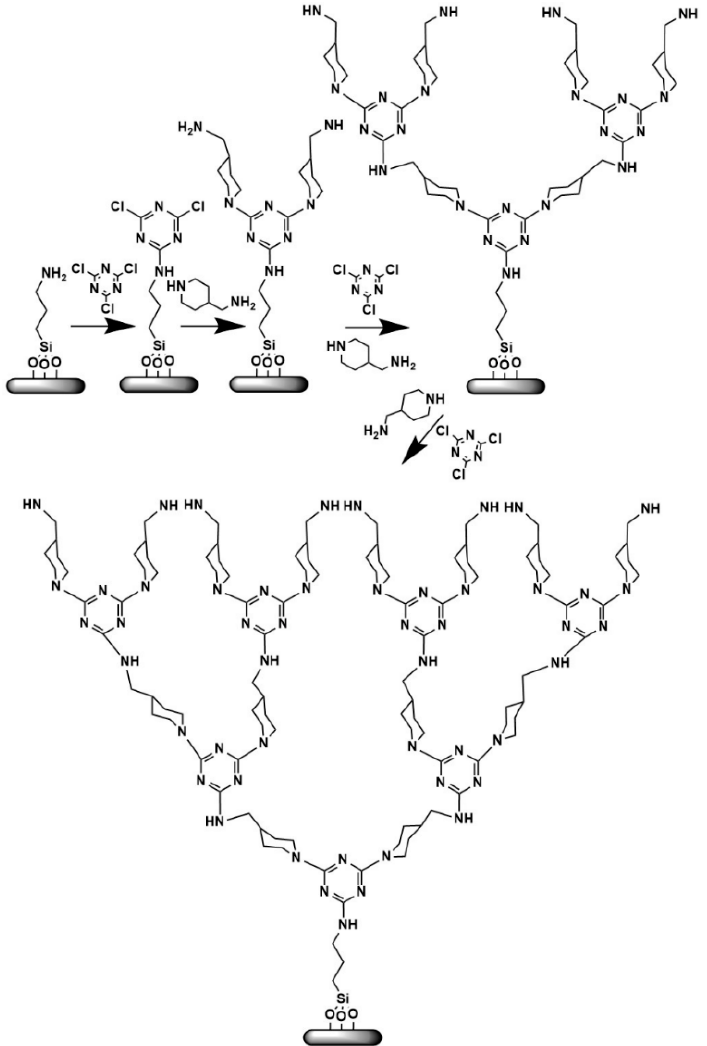
Figure 16. Evolution stages of melamine-based dendrons (Reproduced with permission from [128]; Copyright WILEY-VCH Verlag GmbH & Co., 2004).